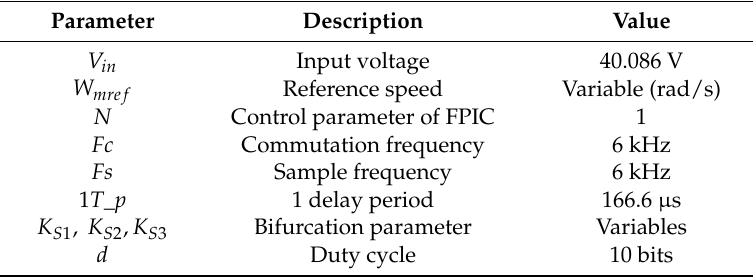
Table 3. Parameters of the ZAD-FPIC controller.